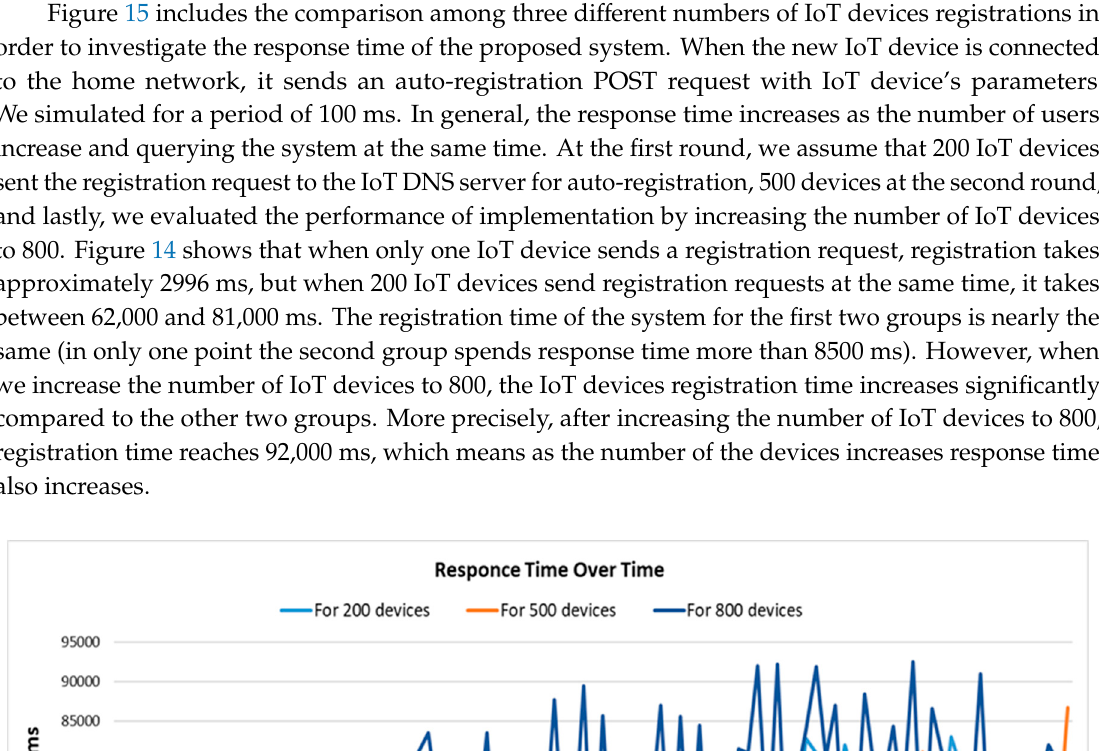
Figure 14. Round Trip Time of the IoT device registration.